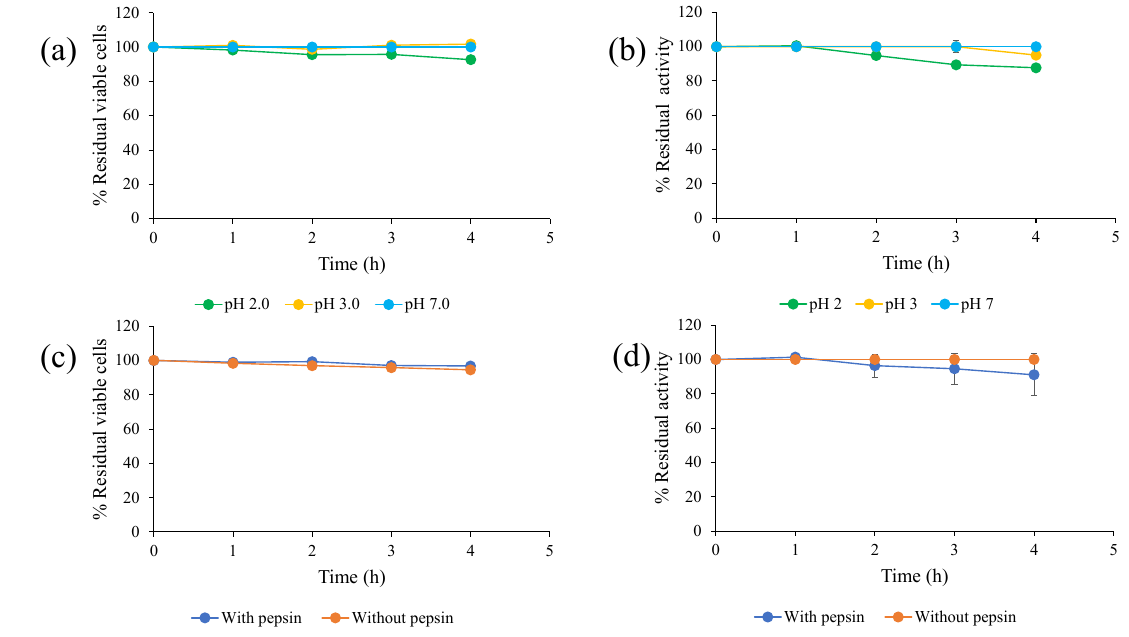
Figure 1. E ff ect of pH 2.0 and pH 3.0 on ( a ) survival of S. ruineniae A45.2 and ( b ) residual CAT activity and e ff ect of pepsin on ( c ) survival of S. ruineniae A45.2 and ( d ) residual CAT activity.